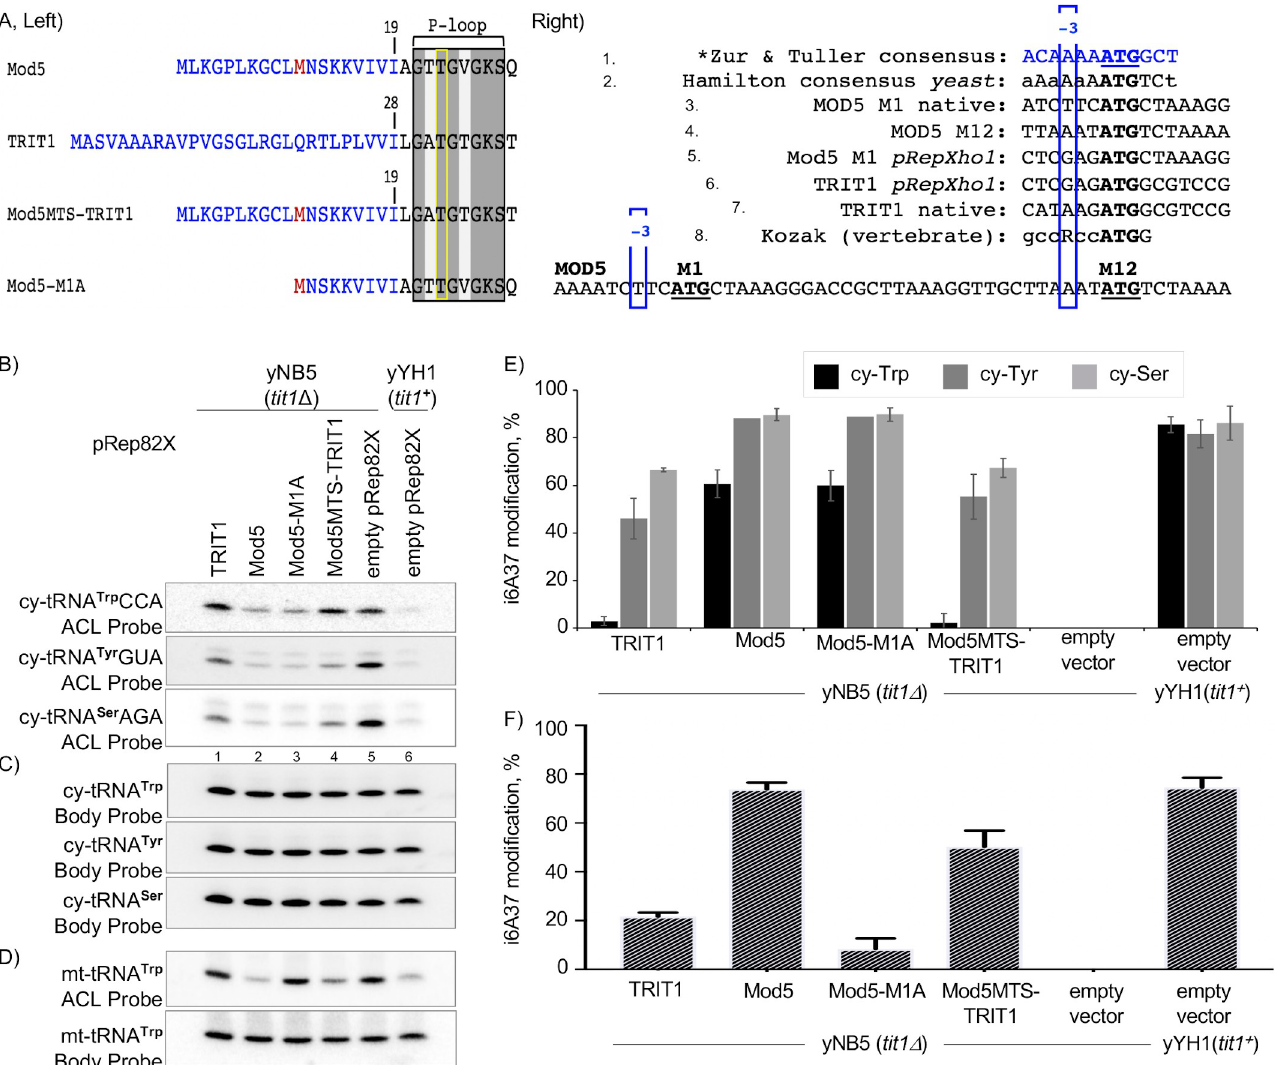
Fig 6. TRIT1 exhibits substrate-specific restriction against cy-tRNA Trp CCA in S . pombe . A) Schematics showing constructs used for analysis of tRNA i 6 A37 modification in S . pombe . Left: amino acid sequence representation of N-termini only, similar to Fig 1; the invariant Thr demarcated by yellow rectangle. The second, alternative translation initiation sites, where present are shown in red. Right: translation initiation contexts of the various constructs used. Lines 1, 2 and 8 represent translation start site consensuses as indicated [101–103], the former of which was derived for S . cerevisiae but applies to other yeasts including S . pombe , at the -3 position. B) The i 6 A37-sensitive PHA6 northern blot assay for three tRNAs from S . pombe expressing IPTases from pRep82X plasmids indicated above the lanes. The blot was sequentially probed with the i 6 A37-sensitive ACL probes to the cy-tRNAs indicated to the left of the panels. C) The body probes for each of the tRNAs in B. D) The same blot as in B-C, probed for mt-tRNA Trp CCA using the ACL and body probes indicated. E) Quantitation of % i 6 A37 modification of the cy-tRNAs from biological replicate PHA6 northern blots as in panels B-C; n = 5 for cy-tRNA Trp CCA and all others except n = 1 for cy- tRNA Tyr in Mod5 and Mod5M1A. F) Quantitation; % i 6 A37 modification of mt-tRNA Trp CCA from biological duplicate PHA6 northern blots; error bars indicate standard deviation